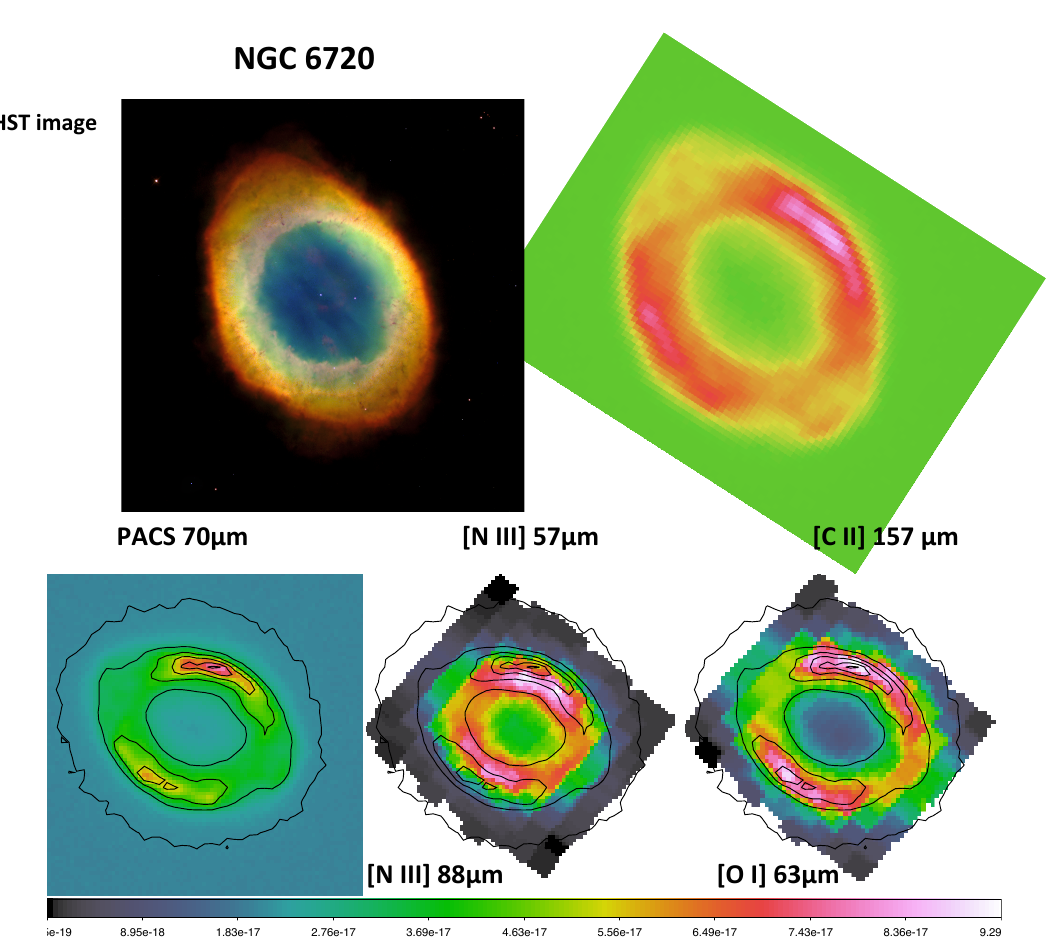
Figure 3. NGC 6720, optical image (HST, WFPC2) and the PACS 70 µ m image at the top, and the IR image with the two spectral images on the